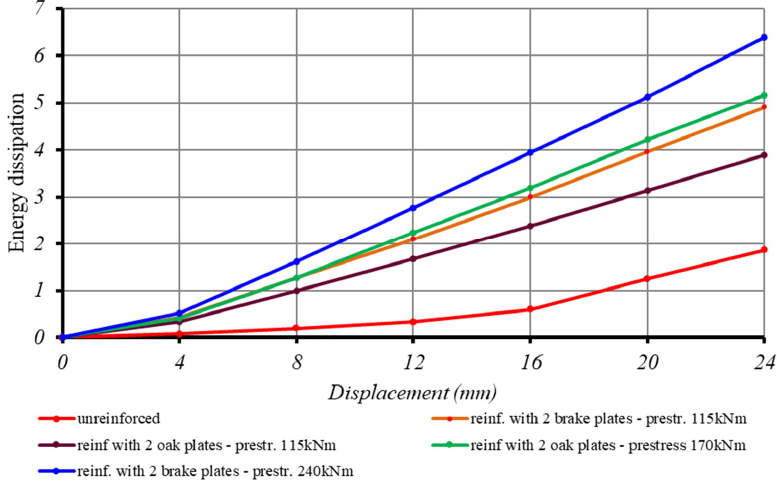
Figure 12. Energy dissipation curves for joints, both unreinforced and reinforced with various types of structural modifications.